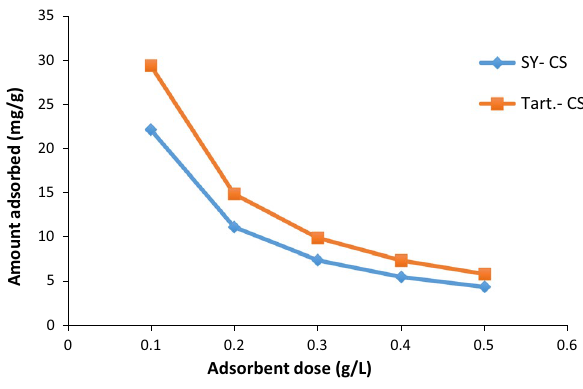
Fig. 6 Effect of temperature on the amount of sunset yellow and tar- trazine dyes adsorbed unto activated cassava